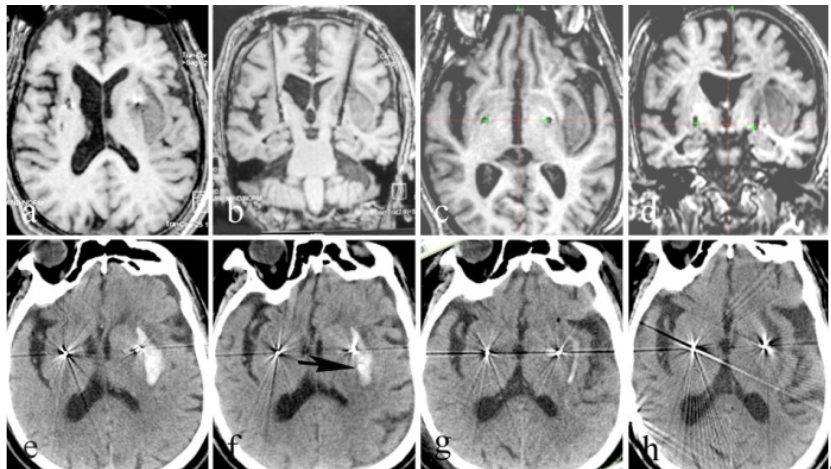
. Figure 4. DBS of the globus pallidus internus. ( a ): The intraoperative 3D T1-weighted image shows low signal around the left electrode. ( b ): A CT scan conducted on 1 day postoperation shows the low density of the ischemic infarct. ( c , d ): T1- and T2-weighted MRI images at 9 months postopera- tion show a slight abnormality around the leads. 4. Discussion Both DAM and DBS had good results in our patients with ST ( p < 0.001). The DAM procedure is performed in only a few neurosurgical departments worldwide, and other authors have reported similar results [12,13]. For instance, Bertrand et al. [6,7,14] reported